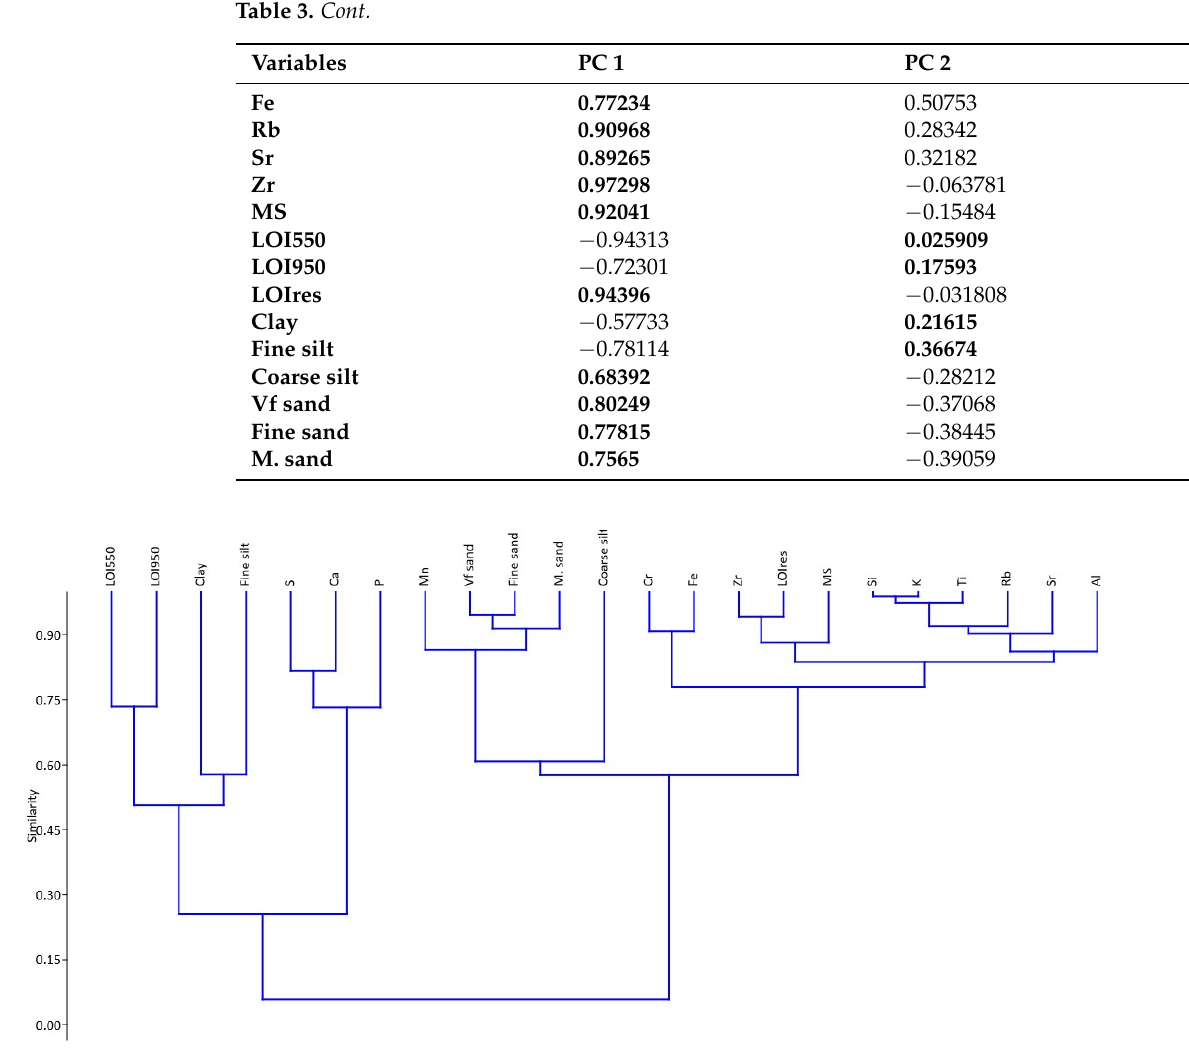
Figure 6. Dendrogram obtained (UPGMA method with Manhattan similarity by PAST 3X) for cluster analysis of observations.